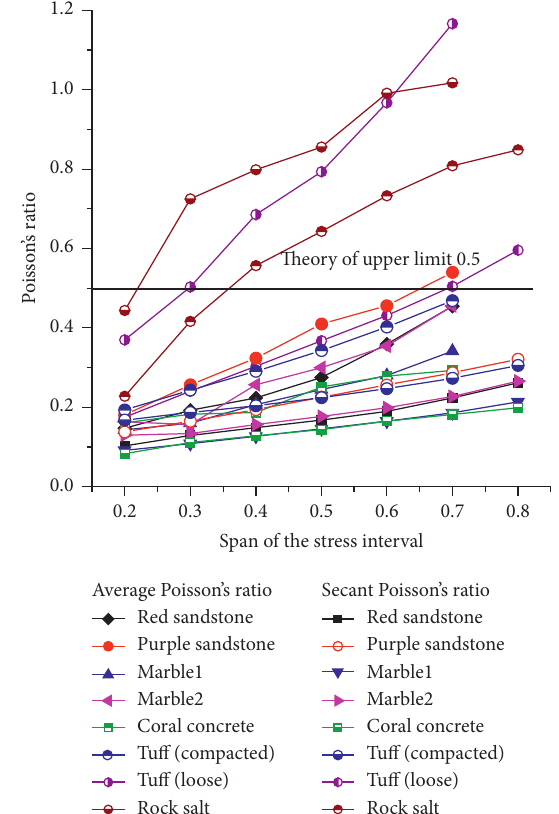
Figure 10: Average and secant Poisson’s ratios with different reference points. The span of the stress interval for calculating the average Poisson’s ratio was fixed at 10% of UCS.